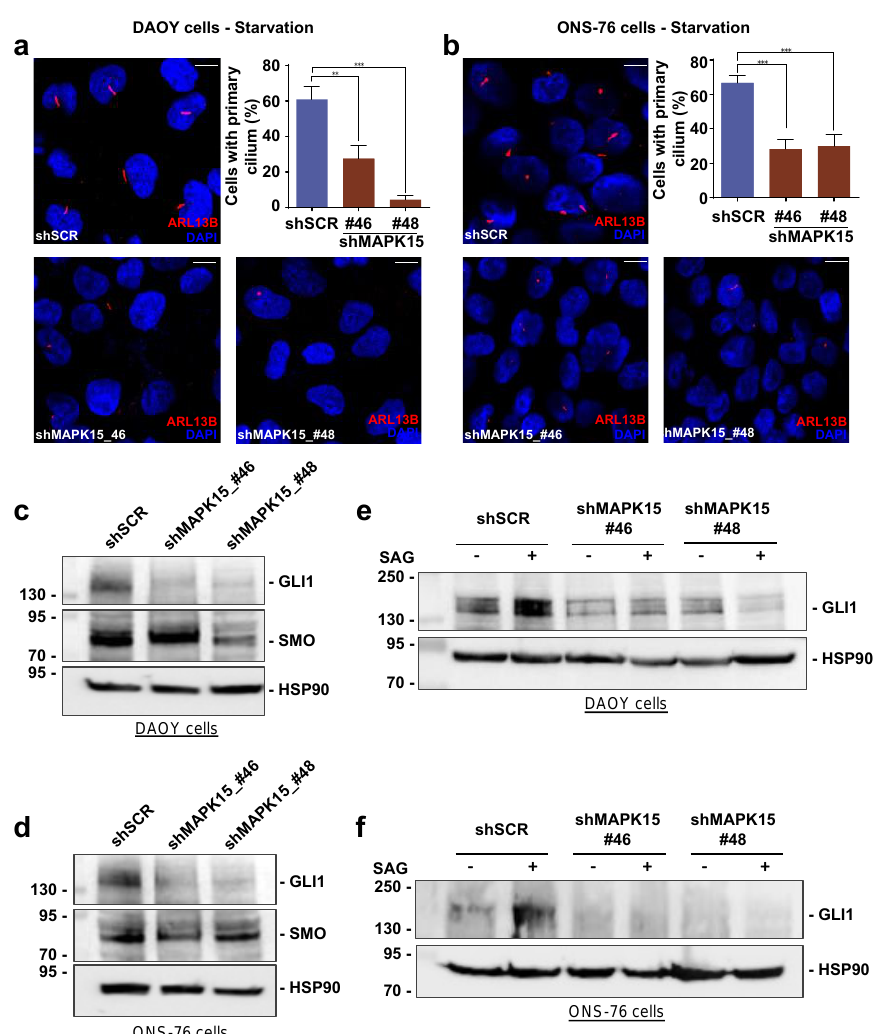
Figure 3. MAPK15 regulates the HH pathway in medulloblastoma cells. DAOY cells ( a ) and ONS-76 cells ( b ) were stably transduced with scrambled (shSCR, negative control) or two different MAPK15 shRNA (shMAPK15_46 or shMAPK15_48) and then analyzed by immunofluorescence, for induc- tion of primary ciliogenesis, upon starvation for 24 h. In these representative images, ARL13B is visualized in red and nuclei in blue (DAPI). Scale bars correspond to 25 µ m. Percentage of primary cilium-positive cell was plotted on the accompanying graphs (upper right panel). ( c – f ) Represen- tative Western blot of GLI1 in DAOY ( c ) and ONS-76 ( d ) stably transduced with scramble (shSCR), shMAPK15_46, or shMAPK15_48. HSP90 was used as loading control. ( e , f ) Western blot of GLI1 in DAOY ( e ) and ONS-76 ( f ) showing that silencing of MAPK15 prevents the increase of GLI1 pro- tein levels upon SAG stimulation. **, p < 0.01, ***, p < 0.001. The uncropped blots are shown in supplementary materials (Figure